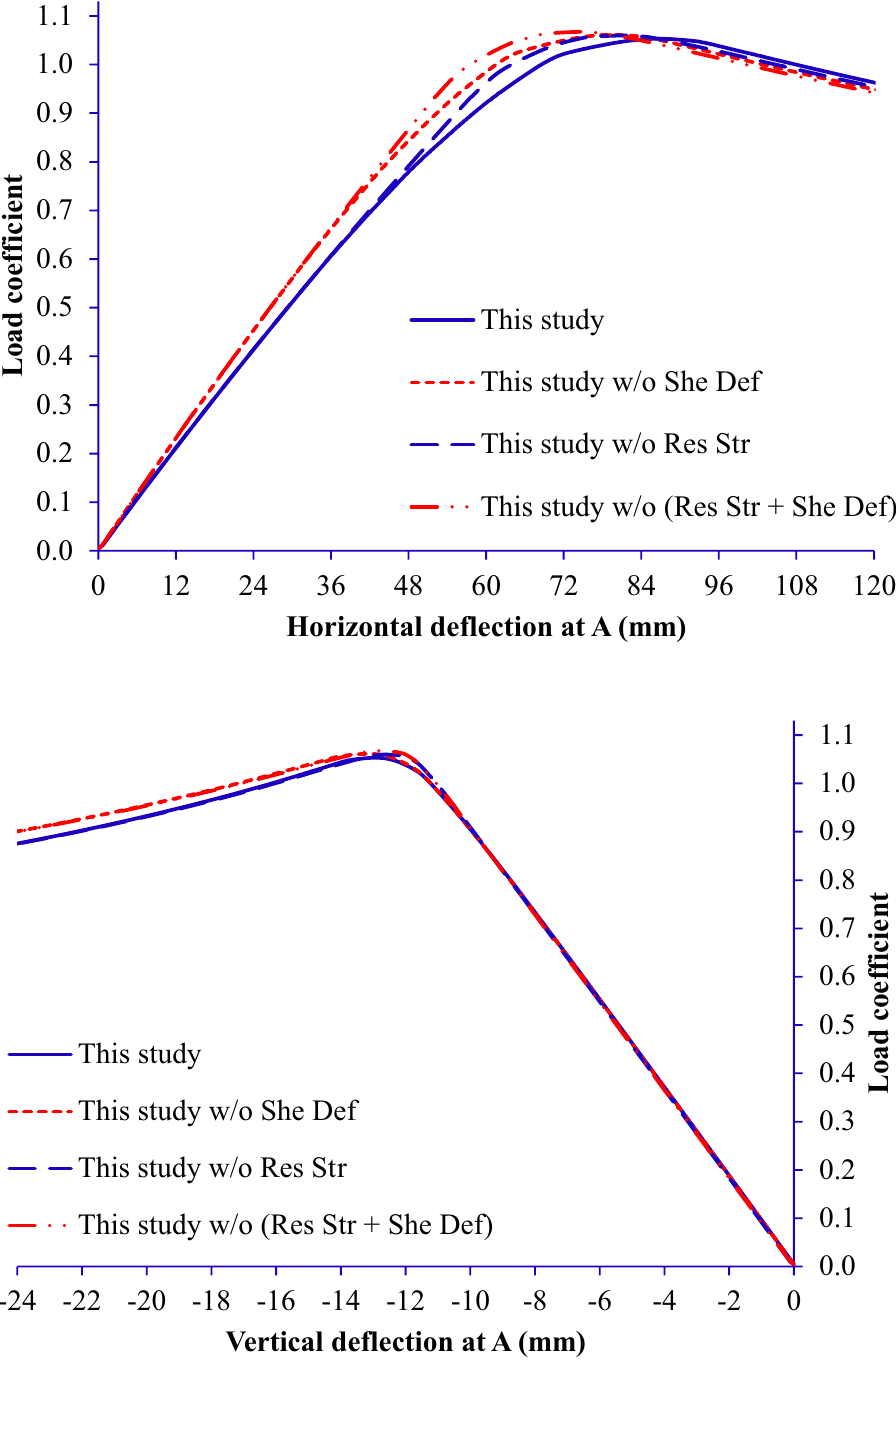
Fig. 26 Load–deflection relationship at A of nine-story frame with different effects